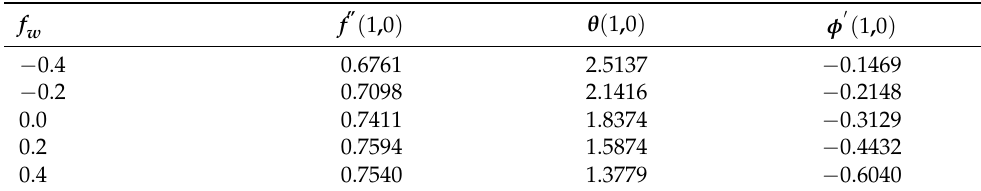
Table 2. Solutions of